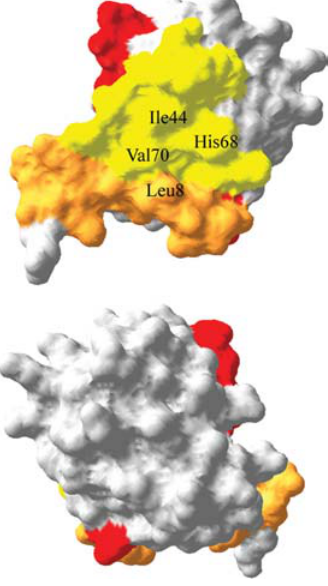
Figure 1 Visualization of the regions responsible for most of the Ub protein–protein interactions (yellow), the fragments most fre- quently found in other proteins (red) and the overlap of both (orange) over Ub molecular surface (both faces of Ub are